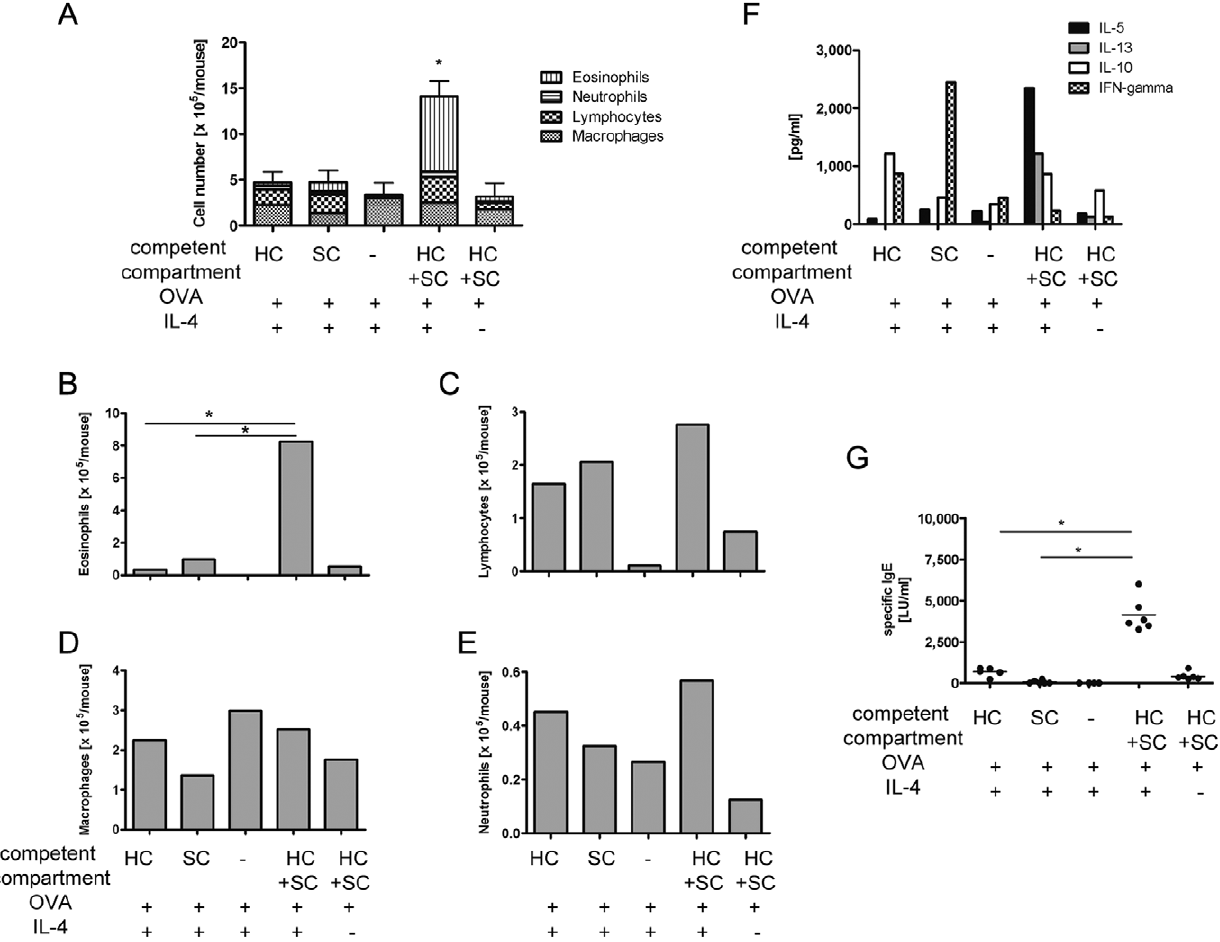
Figure 1. IL-4 facilitates airway sensitization by acting on hematopoetic and structural cells. Chimeric mice, expressing STAT6 in either SC, HC, neither or both were sensitized intranasally with 5 m g OVA in combination with 1 m g IL-4 for three consecutive days and challenged with 25 m g OVA for four days. Animals sensitized with OVA only served as controls. Analyses were performed two days after last challenge. A: BAL cell differentiation of STAT6 chimeric mice. B–E: BAL cell distribution of STAT6 chimeric mice, B = eosinophils, C= lymphocytes, D= macrophages, E= neutrophils. F: OVA-specific cytokine expression in lung draining lymph nodes from STAT6 chimeric mice on day 3 of culture. G: OVA-specific IgE in serum of STAT6 chimeric mice. SC = structural compartment. HC = hematopoetic compartment. LU = laboratory units. *p , 0.05 by Mann-Whitney- U-test compared to all other variables. Representative experiments of n=2–8 experiments.